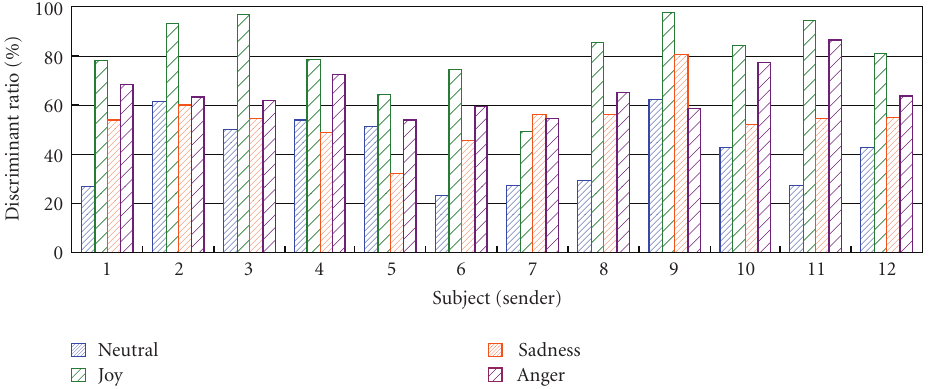
Figure 25: Discriminant ratio as a function of emotions and subject (sender).